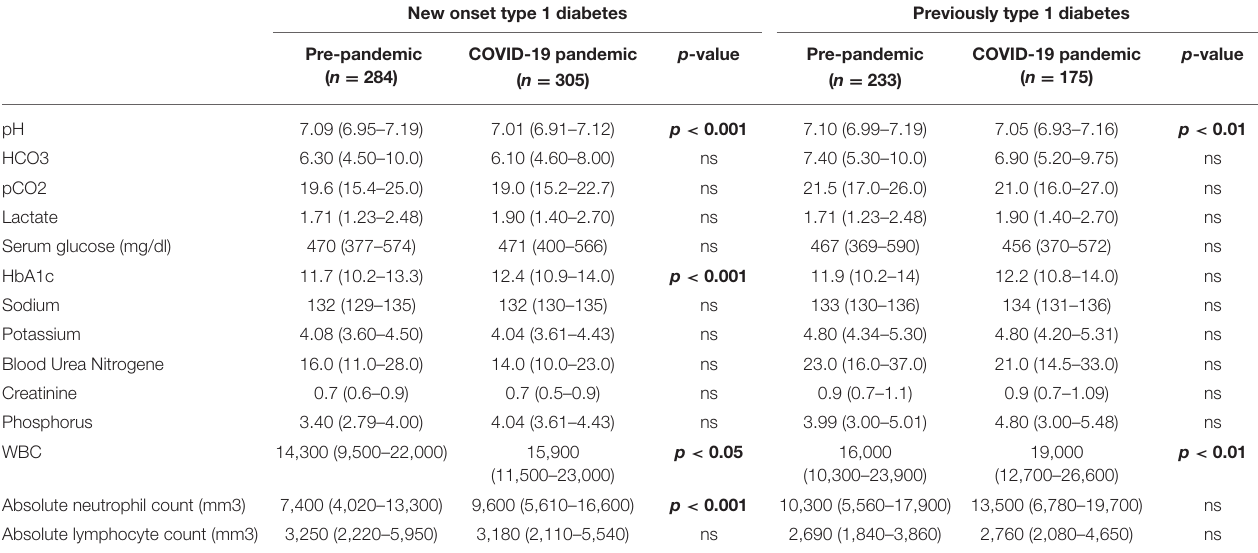
TABLE 4 | Laboratory features of new onset type 1 diabetic children with DKA during pre-pandemic and COVID-19 pandemic